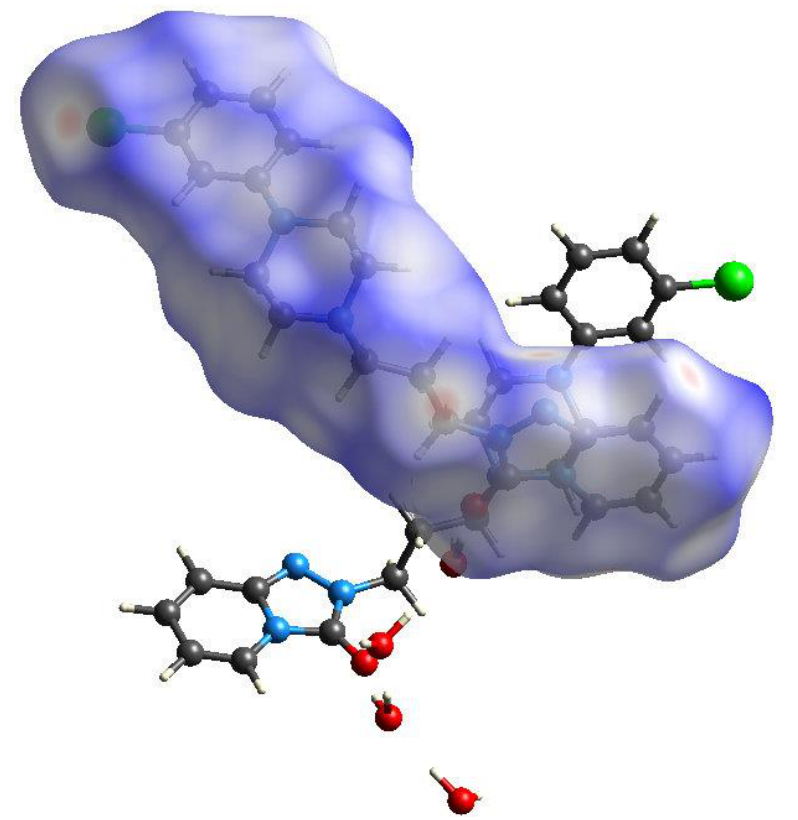
Figure 10. The Hirshfeld surface for the C1 molecules in γ -C 19 H 22 ClN 5 O·2H 2 O mapped over d norm (−0.61 to 1.57 arbitrary units).